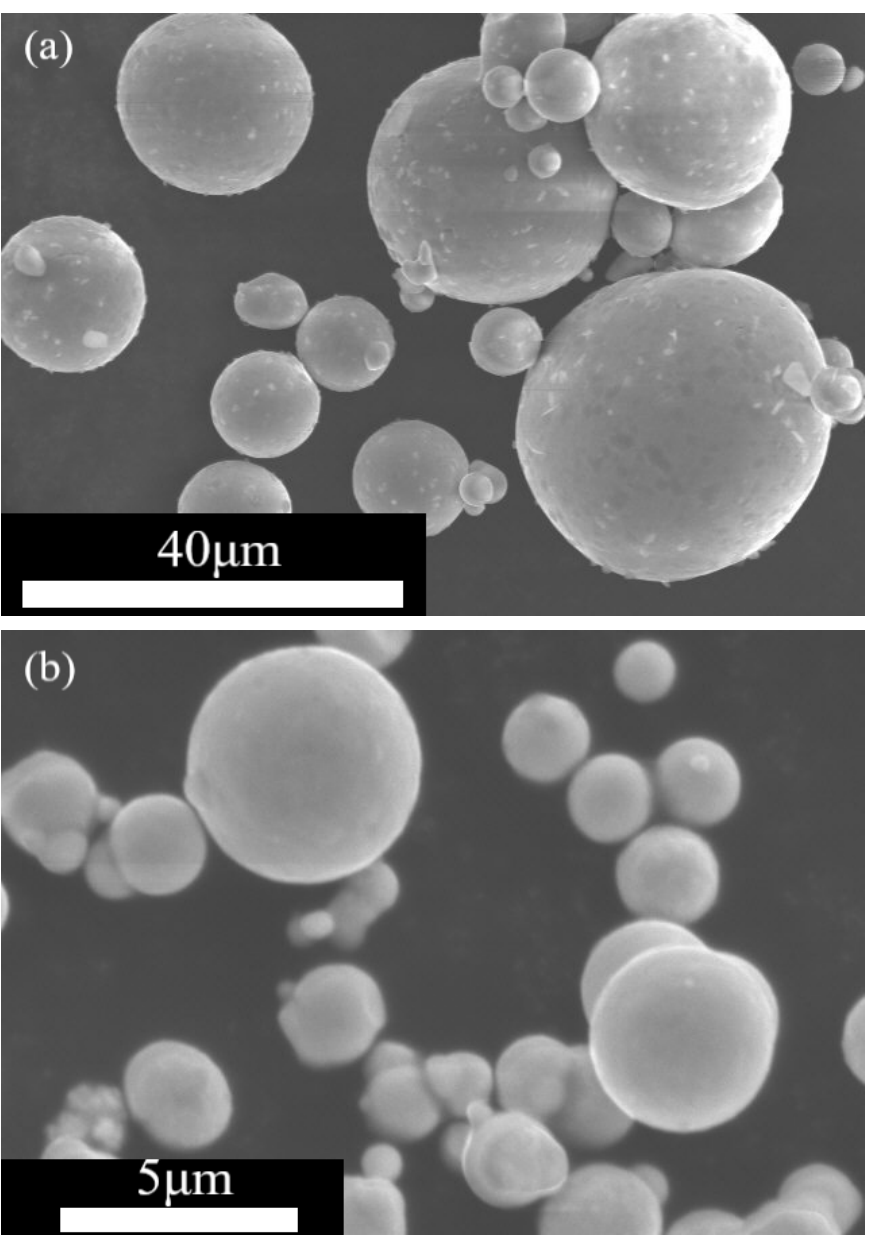
Figure 1. SEM images of ( a ) amorphous FeSiCrB alloy powder and ( b ) carbonyl iron powder. The samples were named nKmC-T, which represents a mixture of 10 n wt% amorphous FeSiCrB alloy powder and 10 m wt% carbonyl iron powder with different heat-treatment procedures (T: W (without heat treatment), B (heat treatment of amorphous FeSiCrB alloy powder at 500 ◦ C example, 3K7C-A: 30% amorphous FeSiCrB amorphous alloy powder and 70% carbonyl